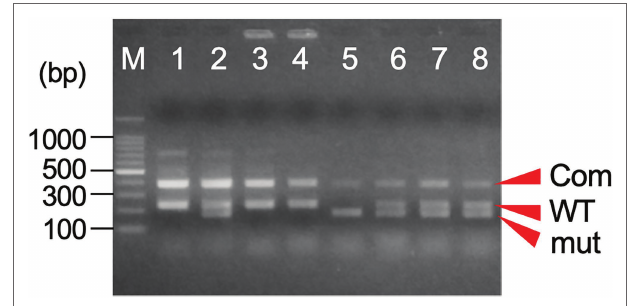
FIGURE 4 | An example of the agarose gel electrophoresis of one-step indel genotyping marker for MS1 diagnosis. The amplified PCR product consists of a common band (Com: 385 bp + 381 bp) and the allele-specific band for wild- type (WT: 233 bp) and/or mutant allele (mut: 183 bp). M: 100 bp ladder marker,